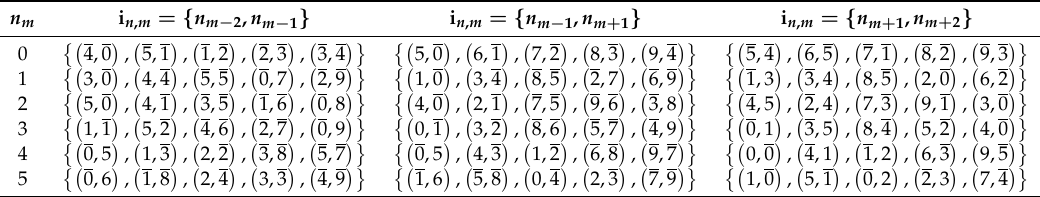
Table 1. (cid:96) = 8 m + n m , where n m , which denotes the n th vertex of the m th polyhedron, is shown on the leftmost column, interacts with i (cid:96) = { (cid:96) (cid:48) , (cid:96) (cid:48)(cid:48) } = { 8 m − 16 + n m − 2 ,8 m − 10 + n m − 1 } ,